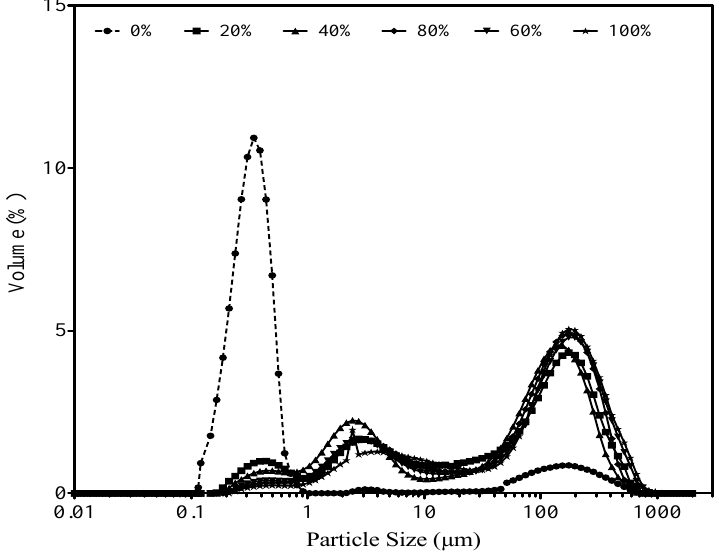
Figure 1. Particle size distribution profile in skim milk with the added powdered skim milk substituted with